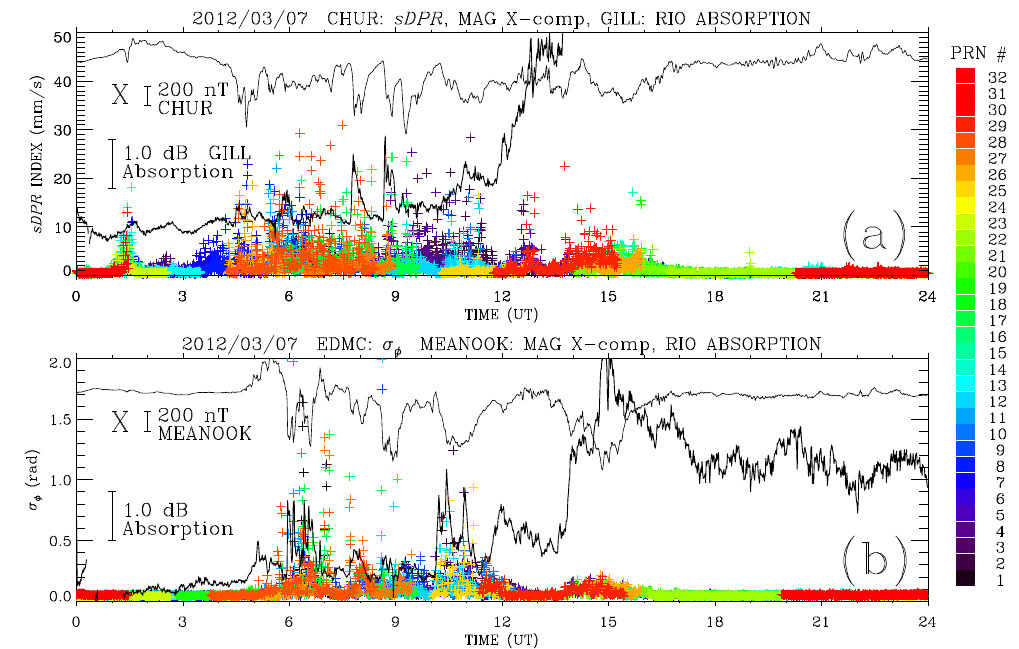
Figure 5. (a) The phase scintillation proxy index sDPR (colored crosses) for elevations above 30 ◦ , the X component of the ground magnetic field in Churchill, and the riometer absorption observed in Gillam on 7 March. (b) The phase scintillation σ (cid:56) from a GPS receiver near Edmonton, the X component of the ground magnetic field, and the riometer absorption observed in Meanook on 7 March.